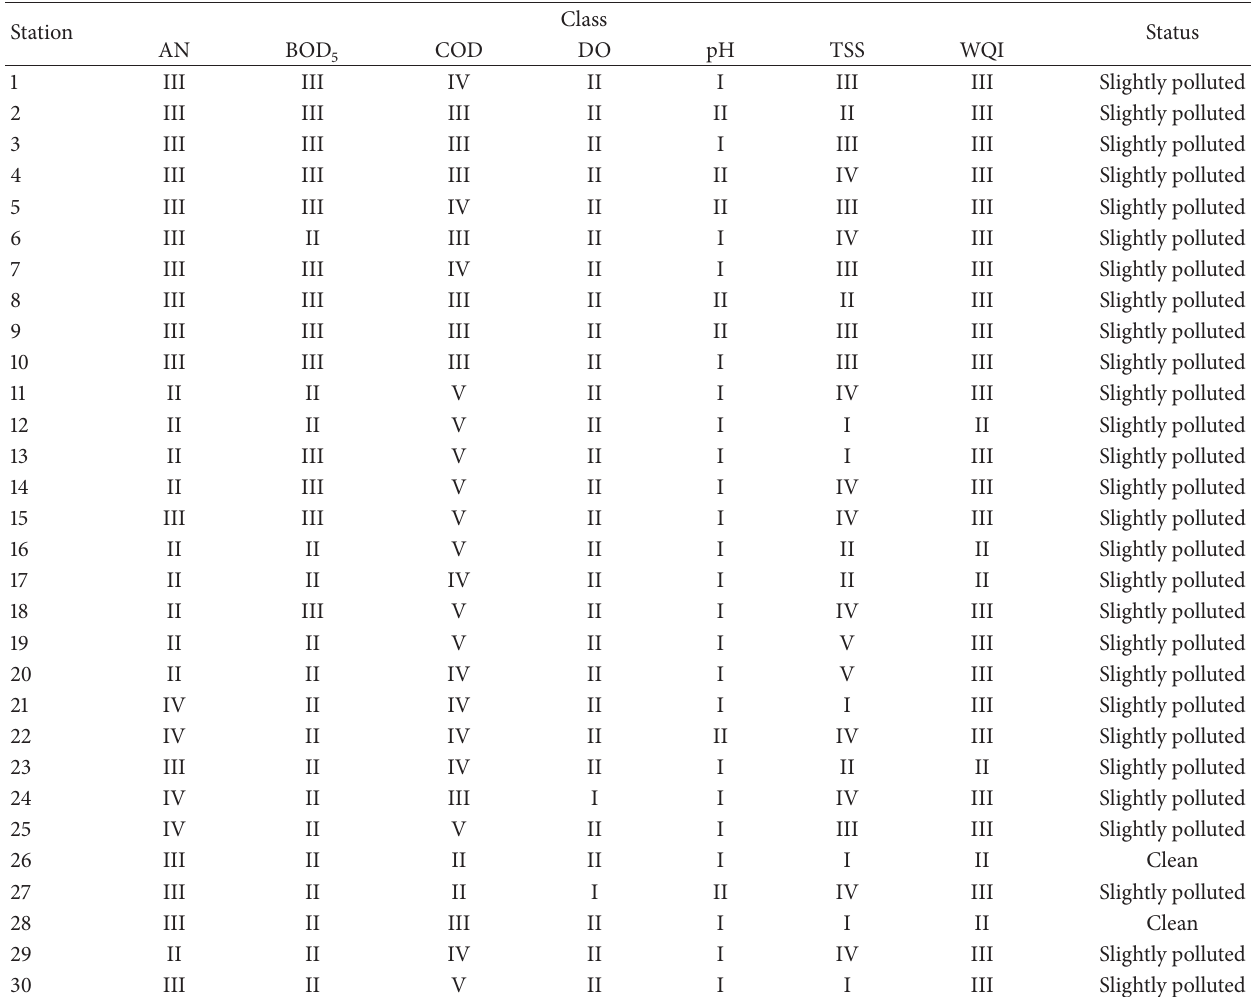
Table 4: Classification of water quality of the Batang Baram from upstream to downstream regions according to WQI.